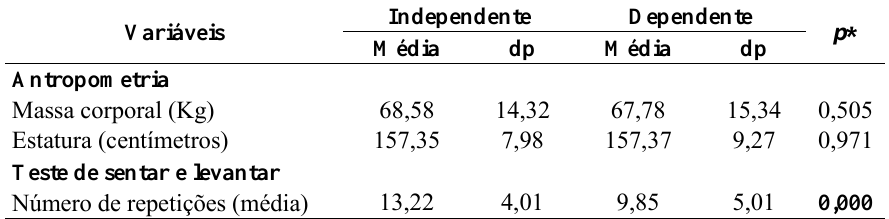
Tabela 3. Distribuição das variáveis antropométricas e número de repetição no teste de sentar em levantar em relação a condição de dependência para realização de atividades instrumentais da vida diária , Uberaba, MG, Brasil,